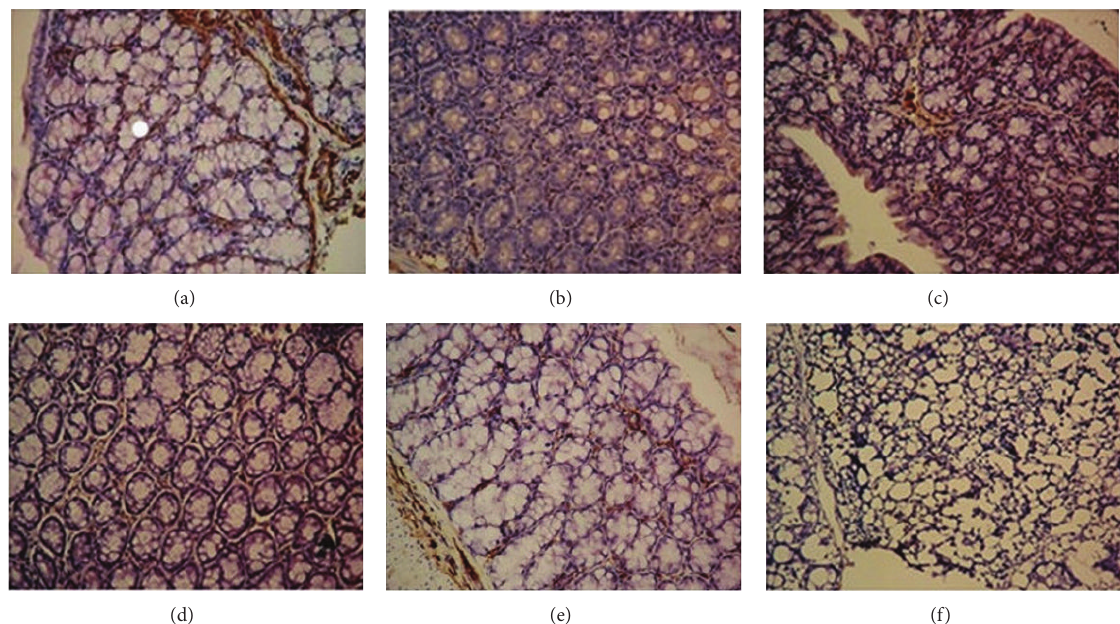
Figure 5: Effects of IL-10 on protein expression of prohibitin ( × 250). Colonic sections of WT mice (a), IL-10 treatment mice at 14 (b) and 16 (c) wk of age and IL-10KO mice at 12 (d), 14 (e), and 16 (f) week were stained